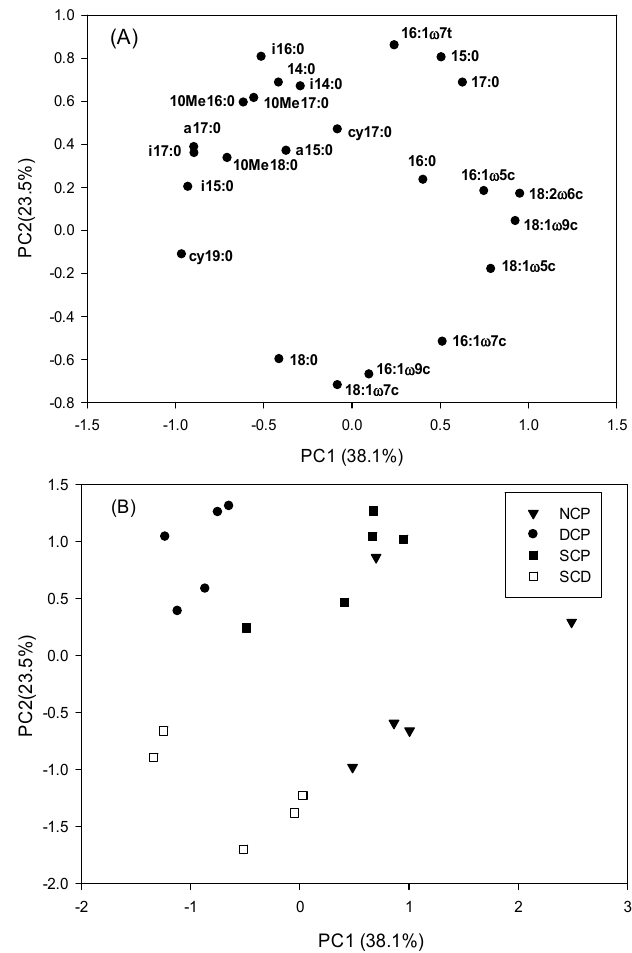
Figure 1. Principle component analysis of microbial phospholipid fatty acids (mole percent of total PLFAs) in natural and managed forest soil. ( A ) Loadings of fatty acid distribution in two PCs; ( B ) Sample distribution by the first two principal components (PC). (NCP, natural Chamaecyparis forest; DCP, Chamaecyparis forest with wood removal; SCP, secondary (regenerated) Chamaecyparis forest; SCD, secondary (reforested) Cryptomeria forest).